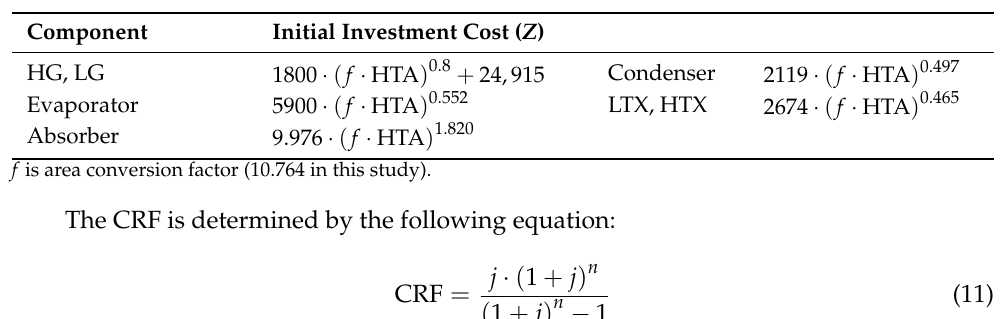
Table 3. Initial investment cost for each component in AC